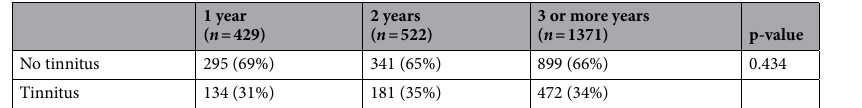
Table 3. Number (%) of subjects reporting tinnitus relative to implant experience. p-value is from a chi- squared test.